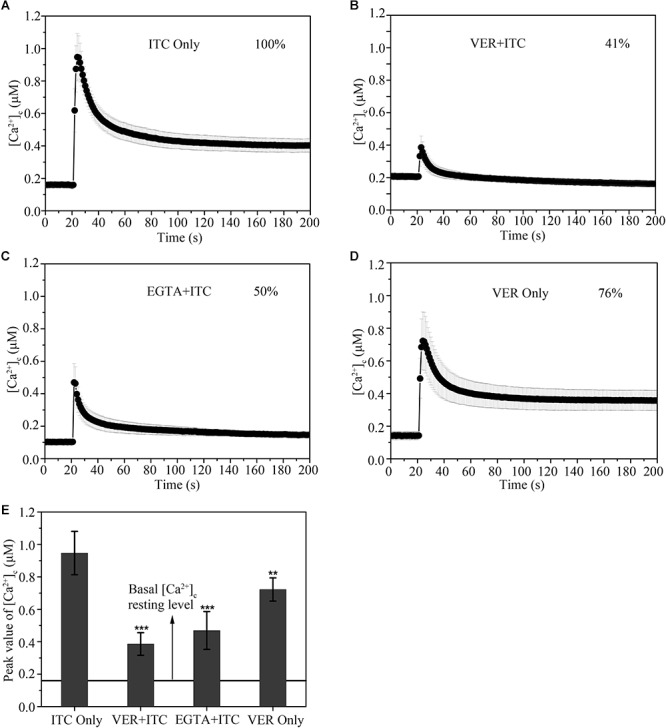
Verapamil blocks the [Ca2+]c transient induced by cellular membrane pressure following itraconazole. (A–D) [Ca2+]c responses to ITC (1 μg/ml) stimulation (A) pretreated with 1 mM VER (B) or 1 mM Ca2+-chelator EGTA (C) for 10 min. [Ca2+]c responses to VER (1 mM) stimulation (D). (E) The peak concentrations of [Ca2+]c are shown in the bar graph, relative to the group with ITC stimulation, ∗∗p < 0.01, ∗∗∗p < 0.001. The prestimulatory basal [Ca2+]c resting level, indicated by the line, is approximately 0.16 μM. In each experiment, average values of six independent replicates are shown with SD error bars.